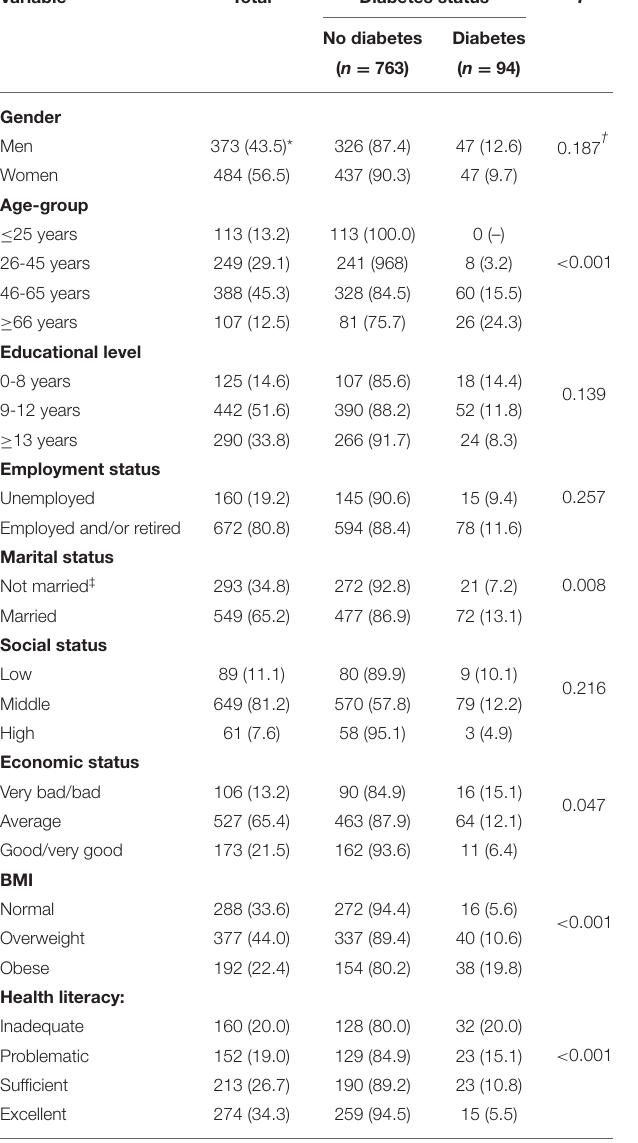
TABLE 2 | Distribution of blood glucose level by socio-demographic characteristics, HL and BMI of study participants. Variable